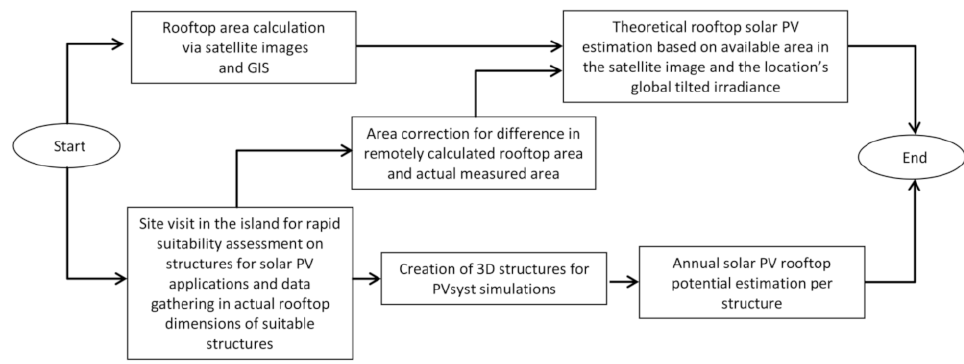
Figure 3. Workflow for the calculation of the rooftop solar PV potential on Gilutongan